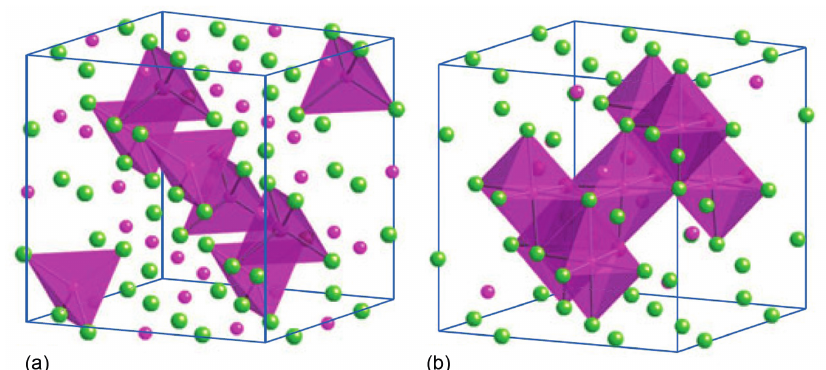
Figure 1: The spinel structure of (a) tetrahedral oxygen around the B cations, and (b) the octahedral oxygen around the A